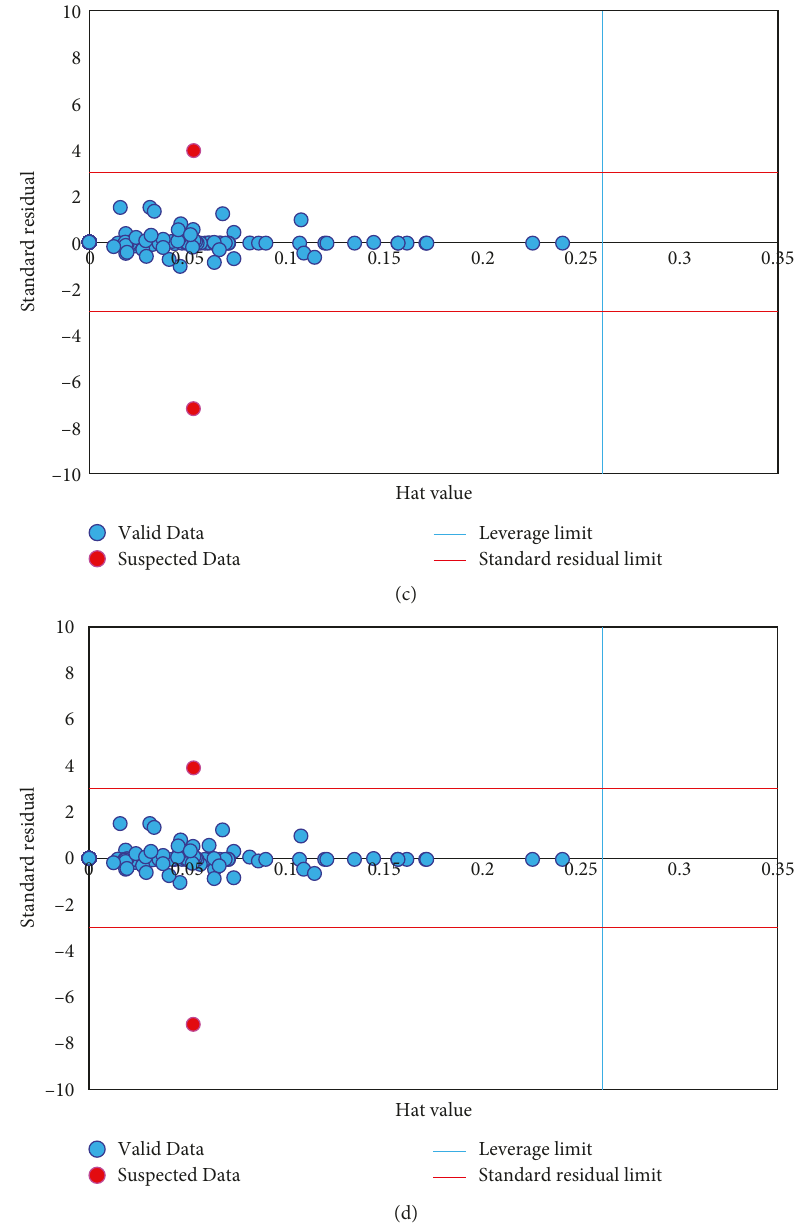
Figure 4: Analysis to determine the effective suspicious points on the proposed models: (a) Matern, (b) exponential, (c) squared ex- ponential, and (d) rational